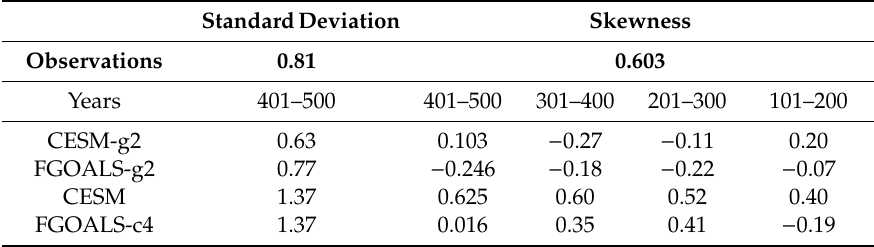
Table 1. Skewness and standard deviations of monthly SST anomalies (SSTA) over the Niño-3 region for the Hadley Centre sea ice and SST (HADISST) observations over the period 1900–1999 and for the four parent models [Community Earth System Model (CESM)-g2, Flexible Global Ocean–Atmosphere–Land System Model (FGOALS)-g2, CESM, and FGOALS-c4) during years 401–500 from the PI-control run. The skewness of the four models during years 101–200, 201–300, and 301–400 is also listed. (The units of standard deviations: